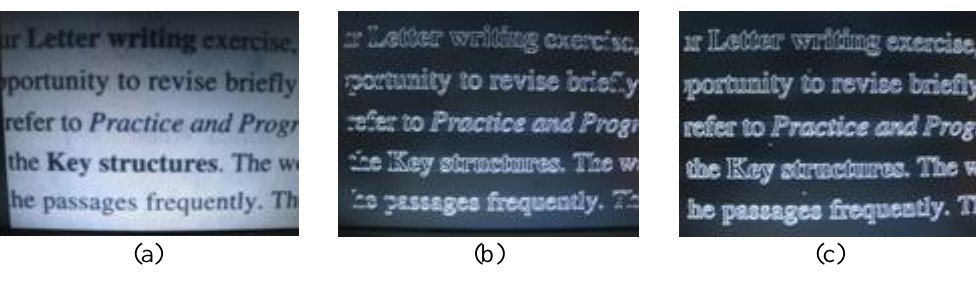
Figure 15. ( a ) Article image; ( b ) Result of [12]; ( c ) Result of proposed canny.